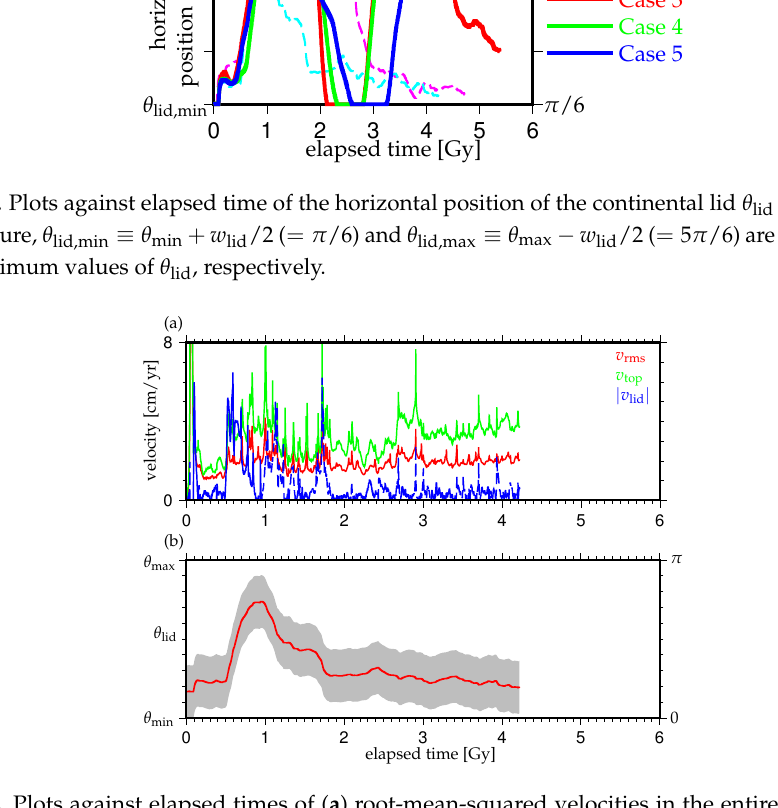
Figure 3. Plots against elapsed times of ( a ) root-mean-squared velocities in the entire domain v rms (red), along the top surface v top (green), and the absolute drifting velocity of the continental lid | v lid | and ( b ) the horizontal coordinate θ lid of the center of the continental lid for Case 2. For the plot of | v | in (a), the solid line indicates v > 0 (namely, θ lid lid lid increases with time), while the dashed line indicates v lid < 0 (namely, θ lid decreases with time). In (b), the shaded region indicates the range of the horizontal coordinate θ where the continental lid covers ( θ lid − w lid /2 ≤ θ ≤ θ lid + w lid